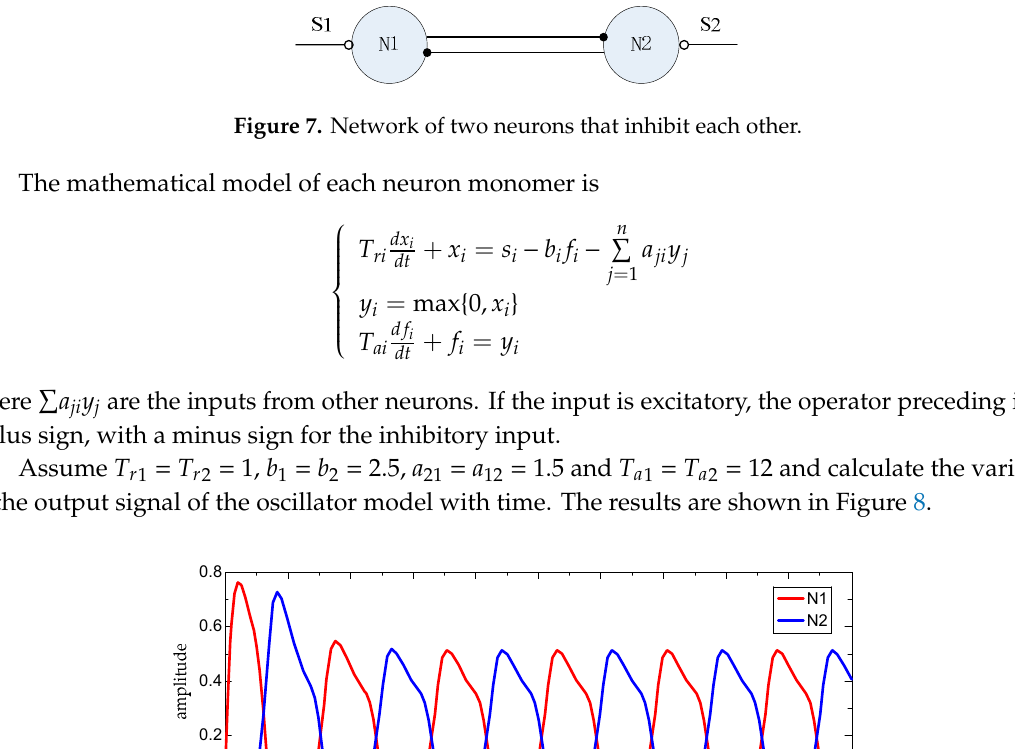
( ) y x f Figure 9. Equivalent model of the original neuron monomer model. According to Equation (29), the modified neuron monomer model only contains one time constant, Tr , and each axon contains a connection weight a to the postsynaptic neuron, which is consistent with the simplified model of self-growing neurons established in Section 3. Moreover, the connection structure shown in Figure 6 has the anatomical basis of the biological CPG network. Known as an inhibitory intermediate neuron directly connected to motor neurons, the Renshaw Cell is involved in the coordination of most extensor and flexor muscles as part of the ipsilateral inhibitory network [14,25]. Moreover, the structure in Figure 6 can be seen in many models of spinal motor nerve circuits [26,27]. A local CPG network for the control of a quadruped robot’s hip joint can be formed with four identical structures, as shown in Figure 10. In Figure 10, N1, N2, N3 and N4 are the output neurons, respectively corresponding to the four hips of the quadruped robot. N5, N6, N7 and N8 are input neurons, and S1, S2, S3 and S4 are step input signals of the same amplitude. N9, N10, N11 and N12